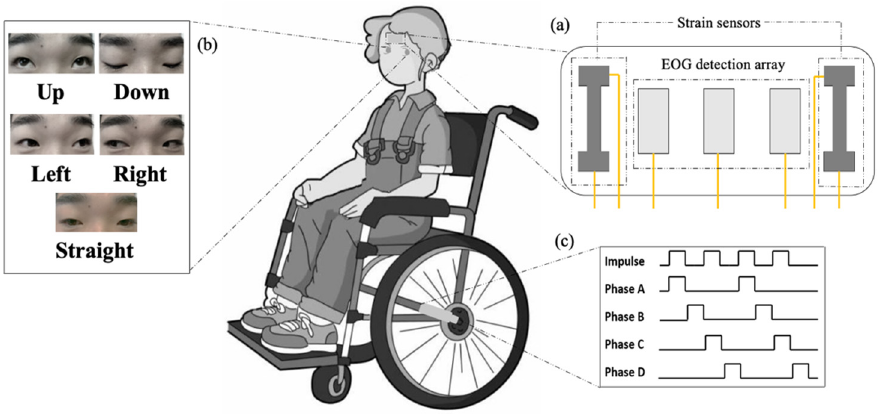
Figure 1. Eye-movement-controlled wheelchair prototype based on a flexible biosensor. ( a ) Structure of flexible biosensor. ( b ) Diverse movement states of eyeballs. ( c ) Pulse signal for driving stepper motors.